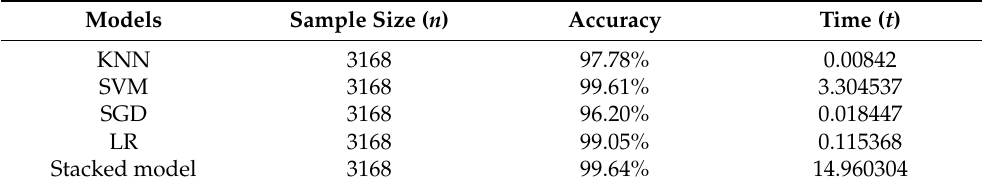
Figure 3. Comparison between the actual values and the predicted values. Table 3. Running time and accuracy for the models, namely, KNN, SVM, SGD, LR, and the stacked model.